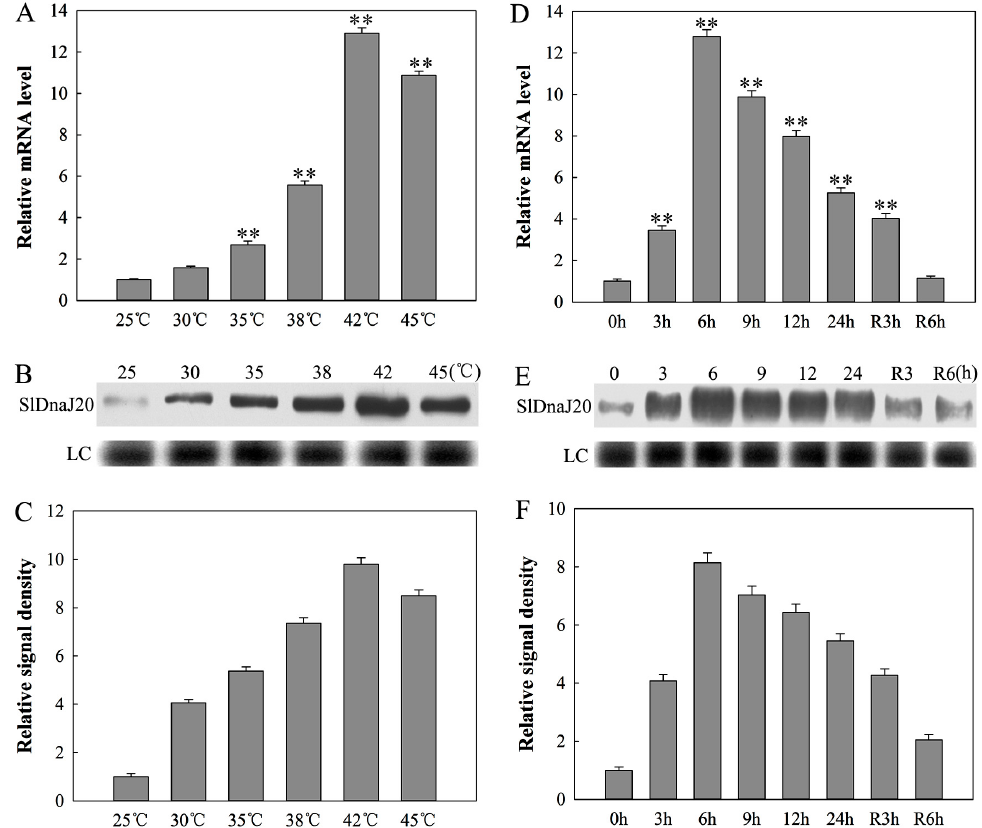
Figure 3. Expression of SlDnaJ20 was induced by heat stress. ( A ) Quantitative PCR analysis of SlDnaJ20 expression under different temperatures for 6 h. ( B ) Western blot analysis of SlDnaJ20 protein levels under different temperatures for 6 h. LC, loading control (part of a Coomassie-stained total protein SDS polyacrylamide gel). ( C ) Image quantification of protein content in ( B ). ( D ) Quantitative PCR analysis of SlDnaJ20 expression in leaves subjected to 42 °C for 0, 3, 6, 9, 12, and 24 h, and recovered for 3 and 6 h. ( E ) Western blot analysis of SlDnaJ20 protein levels in leaves subjected to 42 °C for 0, 3, 6, 9, 12, and 24 h, and recovered for 3 and 6 h. LC, loading control (part of a Coomassie-stained total protein SDS polyacrylamide gel). (F ) Image quantification of the protein content in ( E ). Columns ( A ) and ( D ) represent the mean ± SD of three replicates. Statistically significant differences with respect to the control are indicated as: ** p < 0.01.